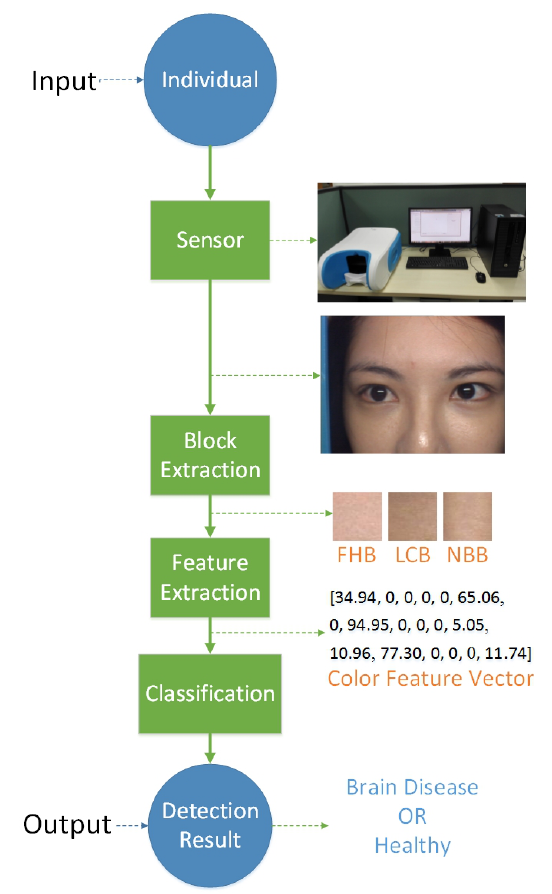
Figure 1. Noninvasive Brain Disease Detection System (NBDS) structure figure. NBDS consists of four main components: ( a ) Sensor; ( b ) Block Extraction; ( c ) Feature Extraction; and ( d )